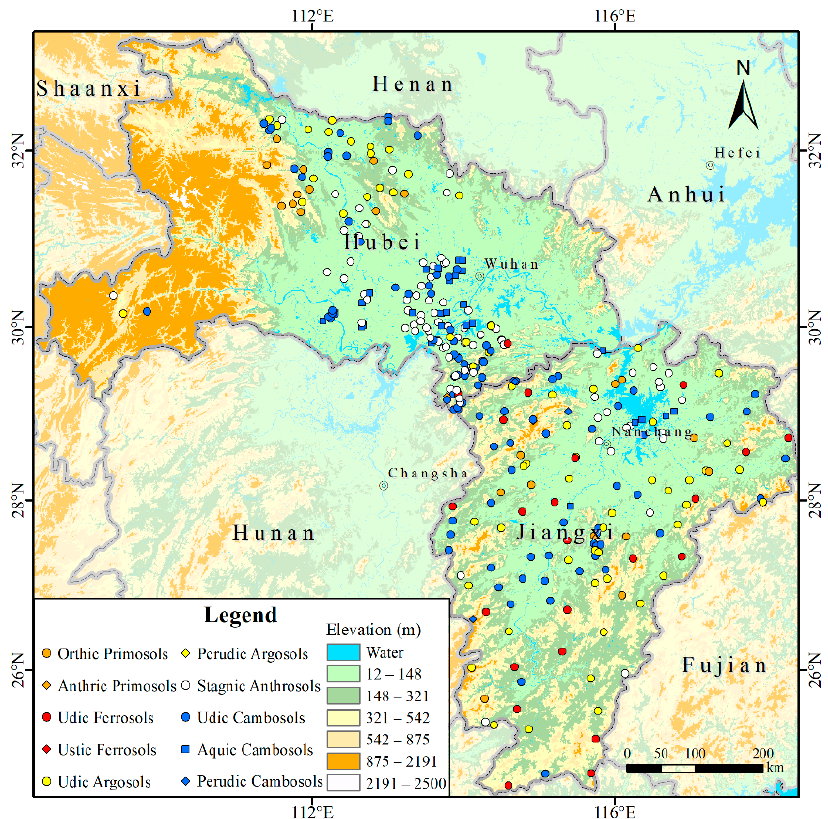
Figure 1. Study area. Hubei and Jiangxi Provinces bordering each other and they are located in the central part of China.